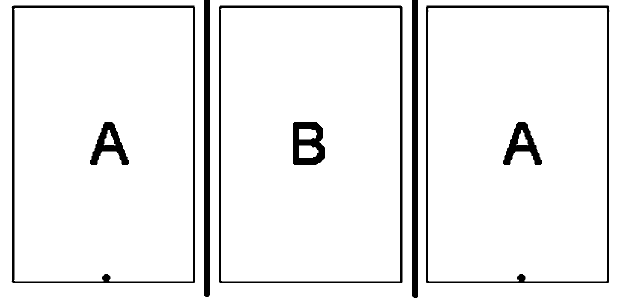
Figure 1. Schematic of the Experimental Setup Two pairs of fry – one in each compartment ‘A’ – were placed on either side of the visual stimulus tank (B). During trials with visual stimuli, the opaque dividers (thick black lines) were removed, and fry could see either a single large cichlid – in PV and PCV trials – or two adult conspecifics – in CV and CCV trials. In trials involving chemical stimuli, stimulus water was dripped into one end of the fry tanks (represented by the black